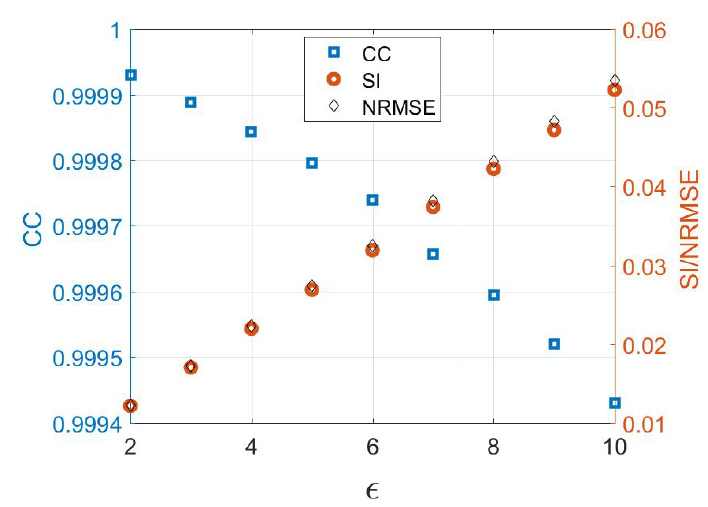
Figure 10. CC, SI and NRMSE of the estimated ˜ B vector.